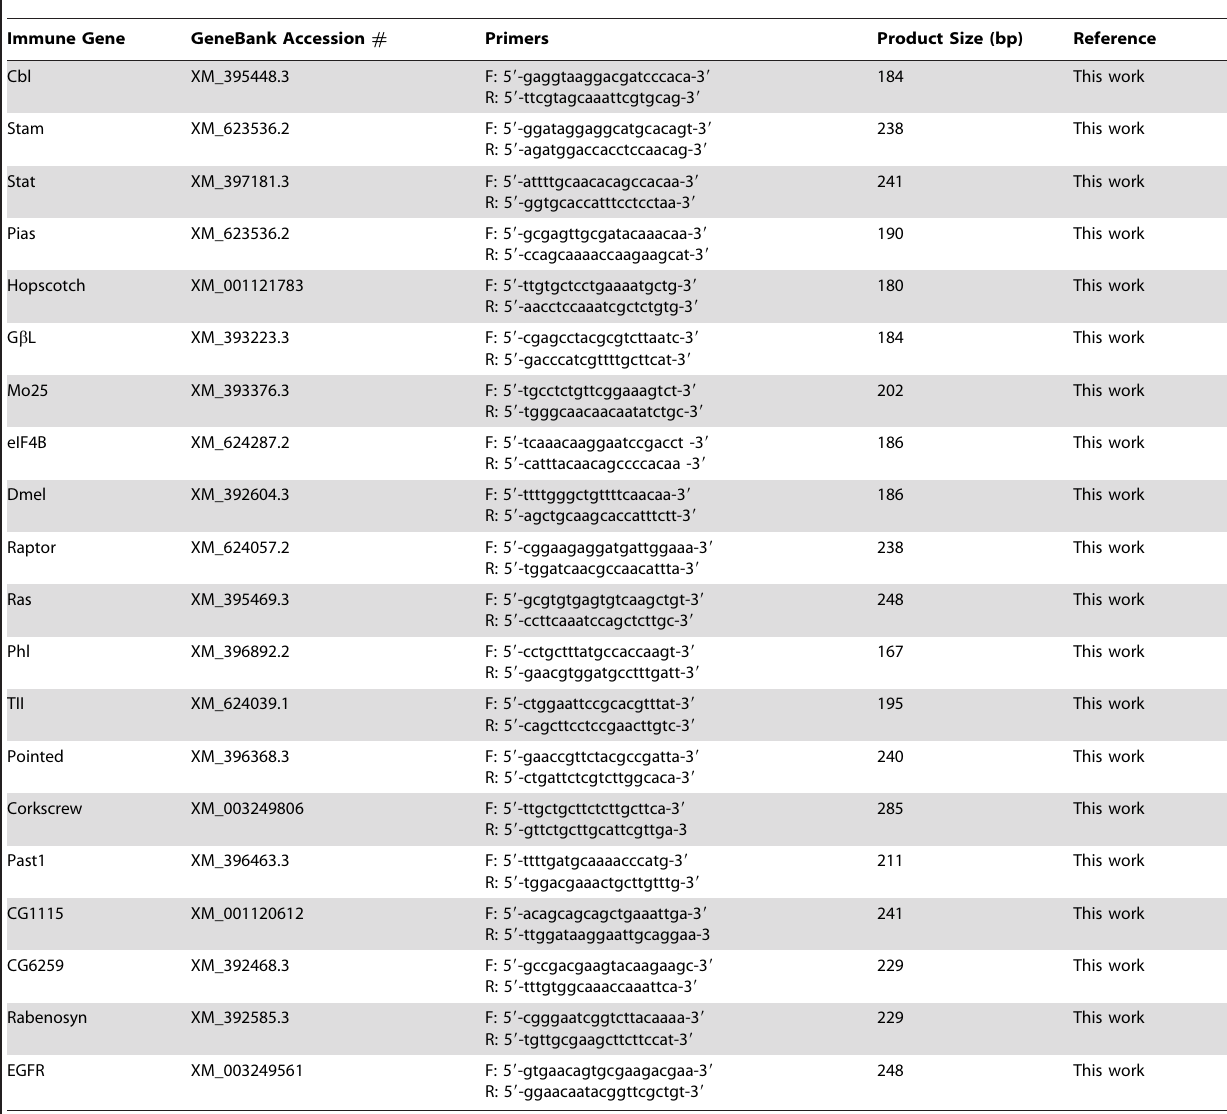
Table 2. Primers of immune genes in the study.